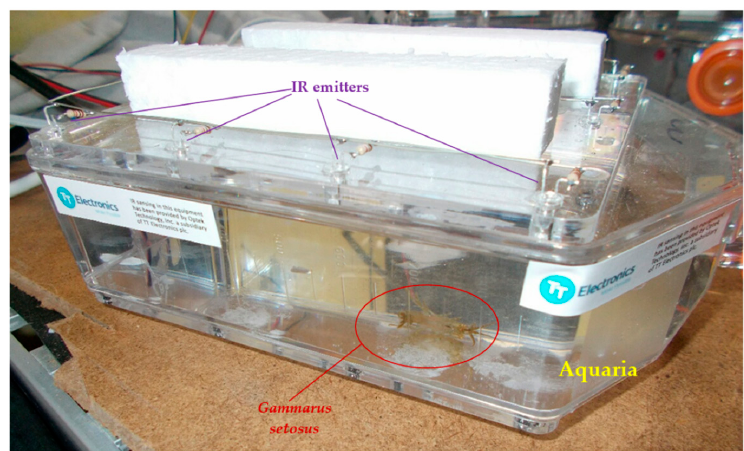
Figure 2. The electronic aquaria, with a Gammarus shrimp inside and with the IR emitters mounted on the aquarium roof. The IR sensors are in the floor of the aquarium (not visible here).